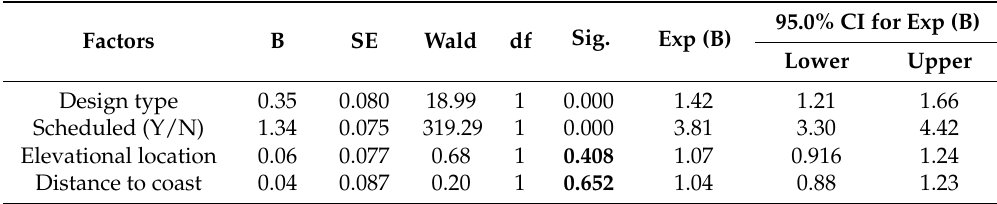
Table 8. Cox regression results for electrical system